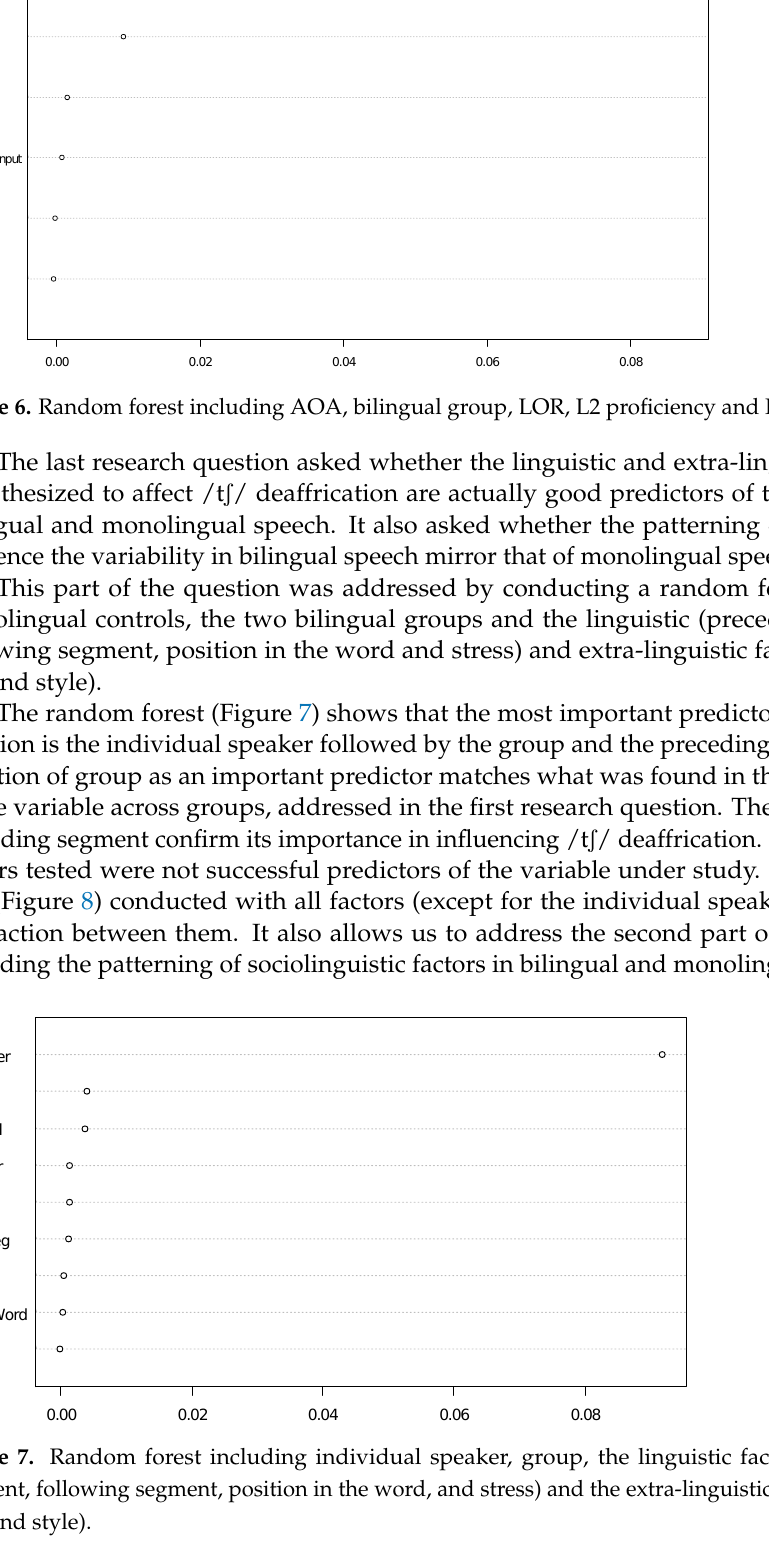
Figure 8. Conditional inference tree of social and linguistic factors that significantly predict the use of /t ʃ / deaffrication. Figure 8 shows that the most important factor is the group, with bilingual speakers producing low rates of [ ʃ ] independently of the other factors. For the monolinguals, the variation is driven by other factors including preceding segment, gender, and age. With regard to preceding segment, a previous pause or /a, n, r, l/ results in lower rate of /t ʃ / deaffrication compared to preceding /s, e, i, o, u/. Similar effects were reported by Cedergren (1973), Jaramillo and Bills (1982), Brown (1989), Amastae (1996) and Méndez (2017). Appendix B (Table A1 and Figure A1) shows the effect of individual preceding segments on the occurrence of [ ʃ ]. Working our way down the inference tree, we observe that male speakers behave differently than female speakers. Male speakers, especially older ones, have overall higher rates of /t ʃ / deaffrication. Female speakers, especially, younger ones, show higher proportions of [ ʃ ]. These findings are rather puzzling, but they could be due to an uneven distribution of age in our sample. So, before proposing possible explanations for this effect, a future study should increase the number of older partici- pants in the sample.